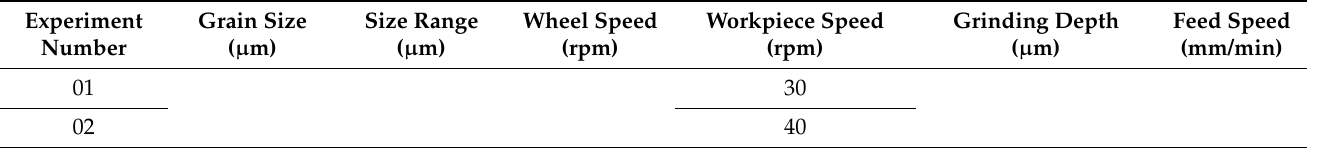
Table 1. Grinding conditions for single-factor